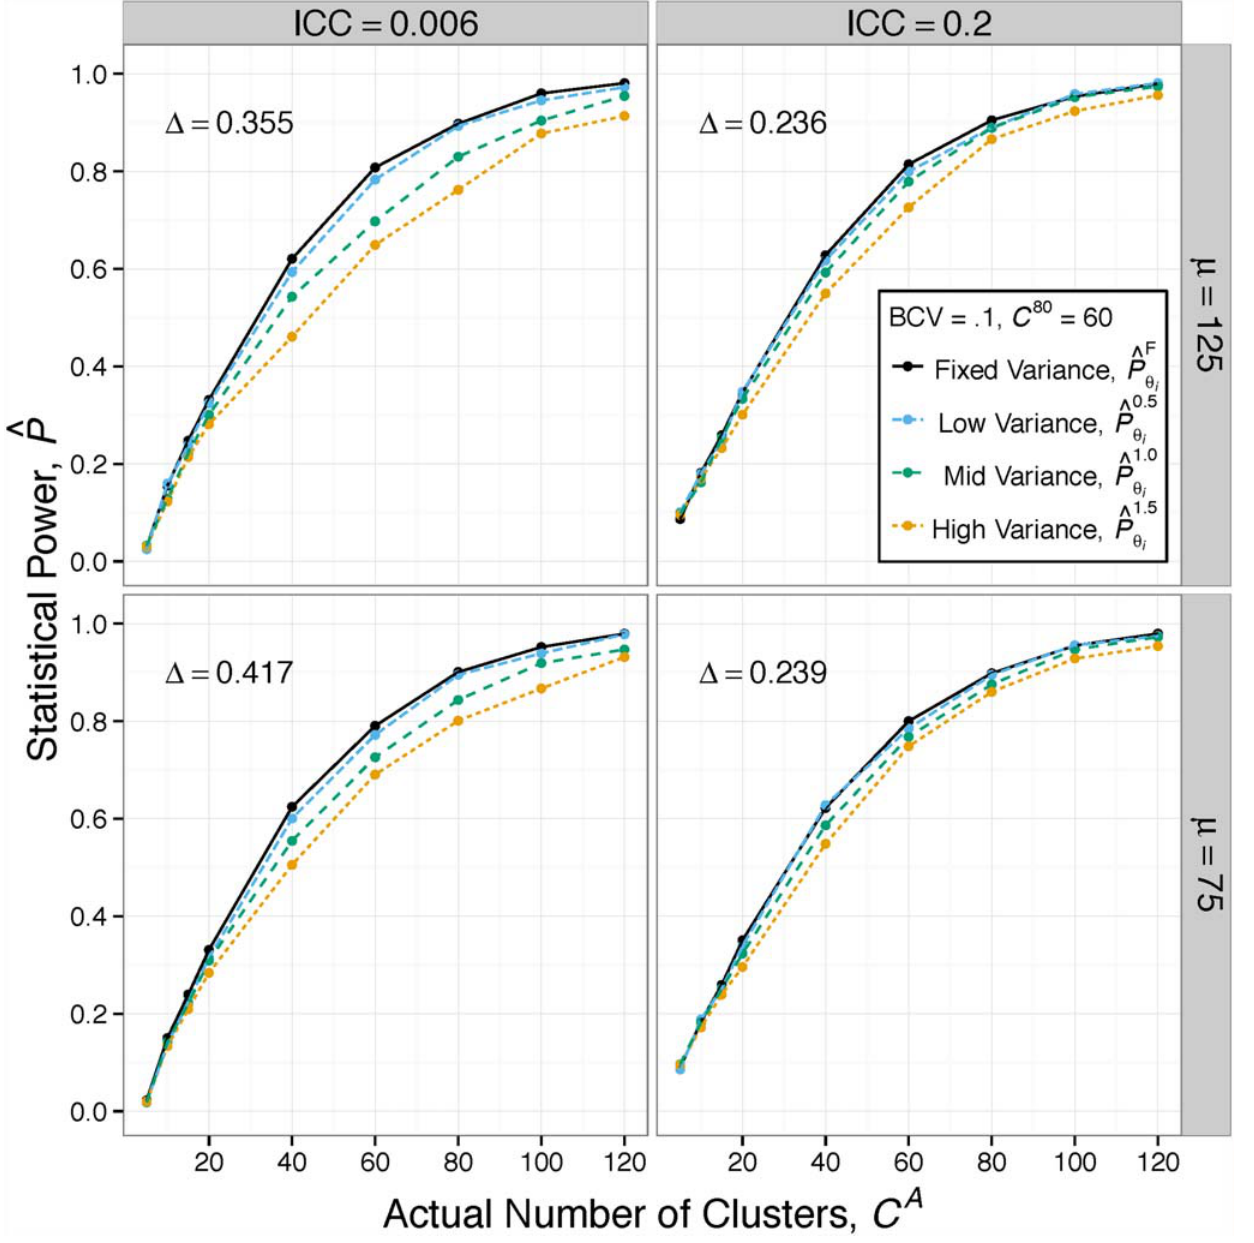
Fig 4. The CRT power curves for two different parameter sets over four levels of cluster size variance. When C A = 60, both fixed cluster size power (^ P F estimates θ i ), the solid, black lines) should equal 0.8. By looking below the point (60, 0.8), one observes that power is lost as the cluster size variance increases in both scenarios. By looking to the right of the point, the observer notices that more clusters are required to attain a statistical power of 0.8 with increased variability.